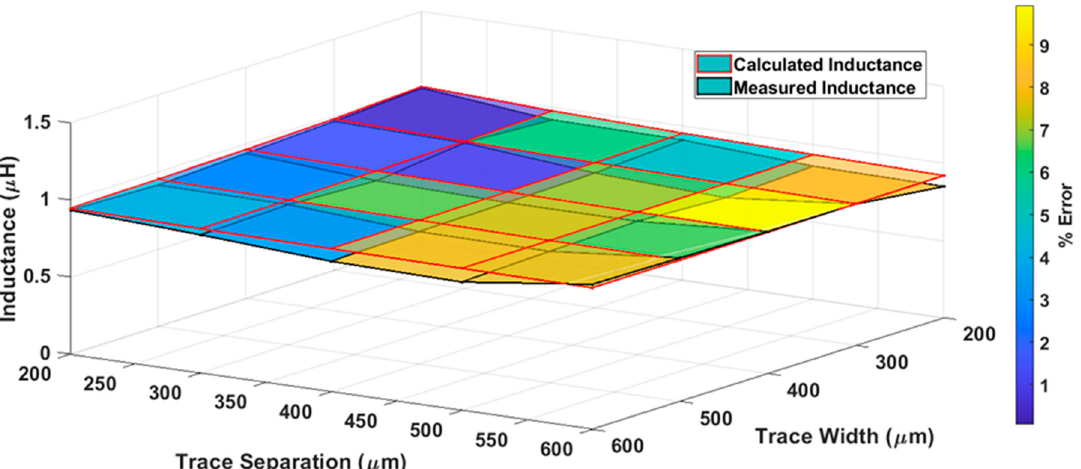
Figure 10. Surface plot of the numerical inductance of the proposed model and measured inductance of the elliptical planar inductor with a color bar to represent the percentage error for different combinations of trace separation ( S ) and trace width ( W ) while major-to-minor ratio ( R ) = 3 and number of turns ( N ) = 5.